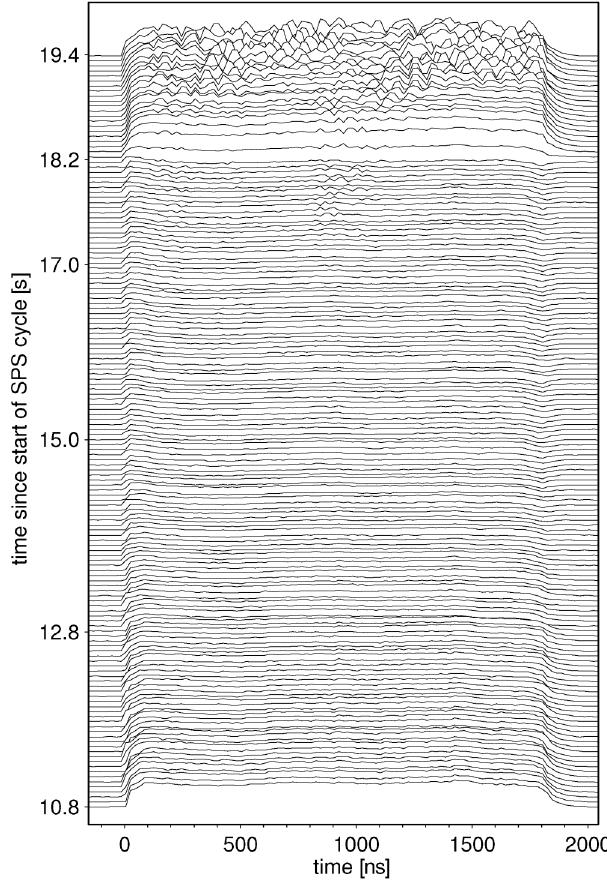
FIG. 10. Mountain range of phase pickup at high beam inten- sities. Operation with rf AM and without 800 MHz .